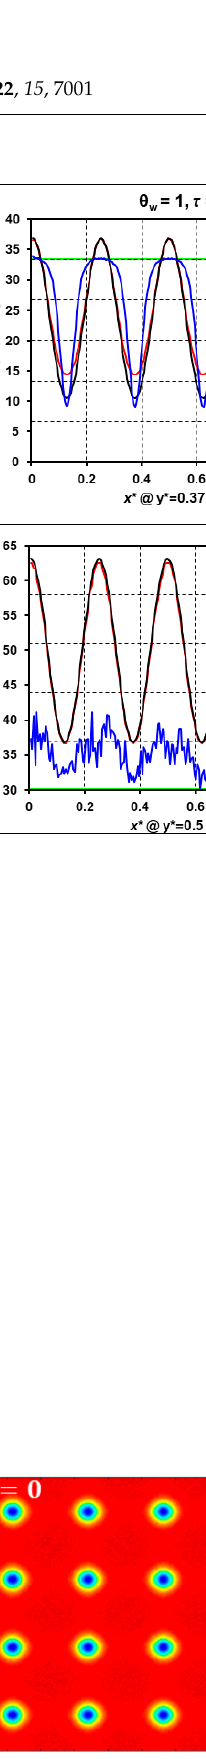
Figure 6. Method A, Case II: Local 𝜺 for array jet impingement–theoretical distribution.